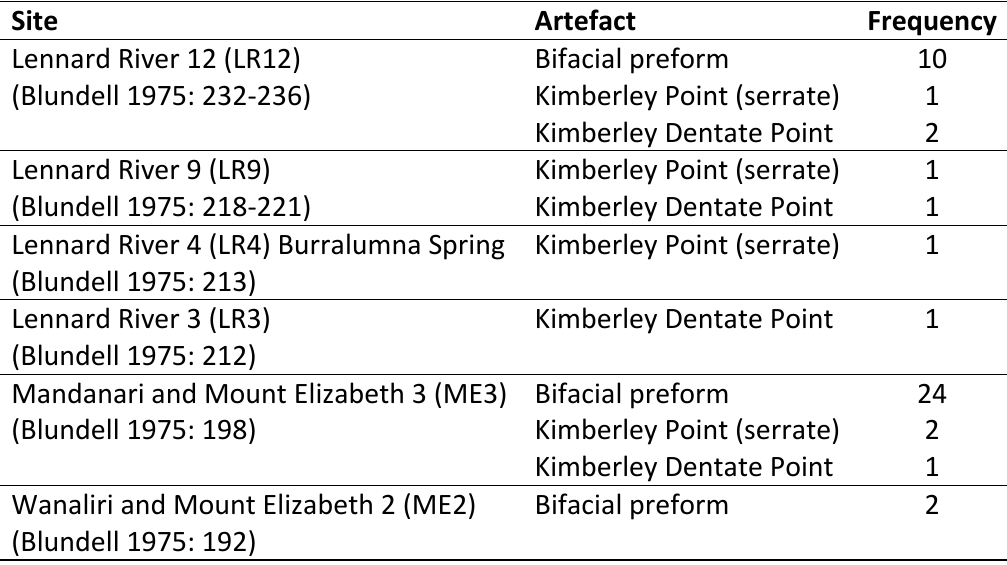
Table 4. Blundell collection artefacts